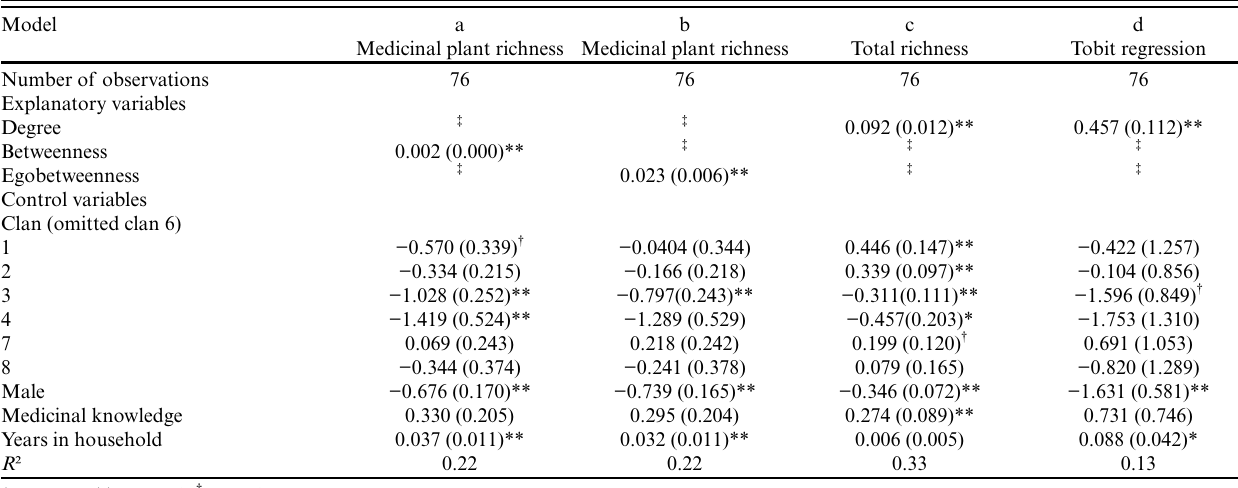
Table 4. Robustness analysis based on variations of model C. Robust standard errors are given in parentheses. See Table 2 for variable definitions and Table 3 for model